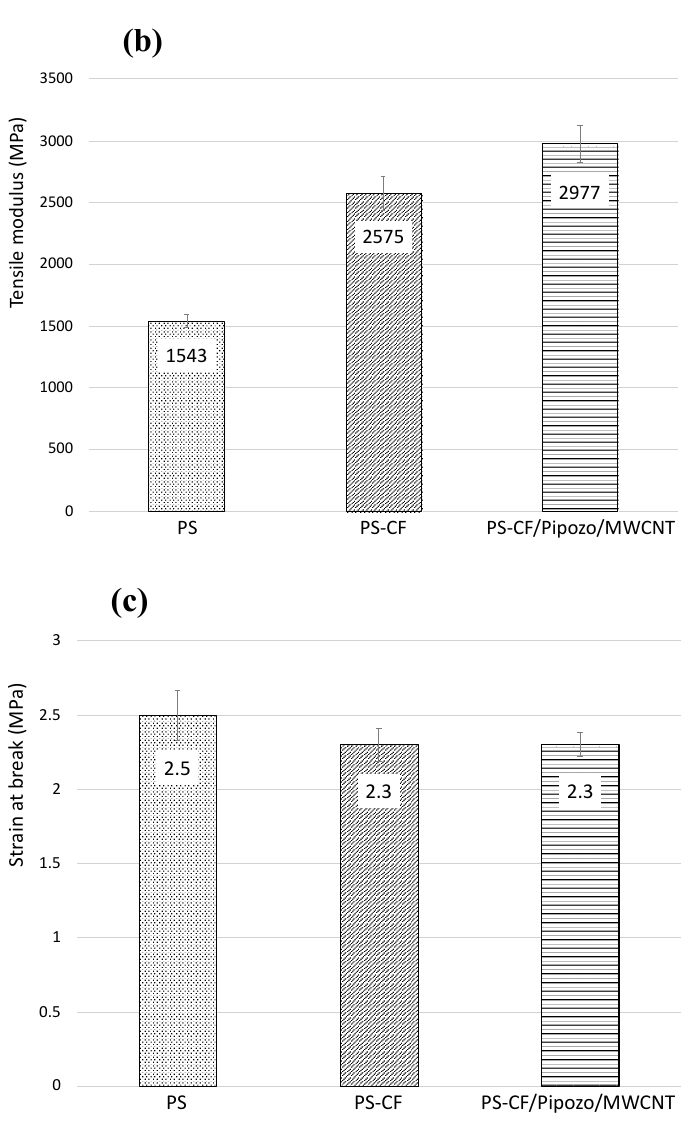
Figure 7. Mechanical properties of various PS composites (PS, PS-CF, PS-CF/Pipozo/MWCNT); ( a ) tensile strength, ( b ) tensile modulus, and ( c ) strain at break.